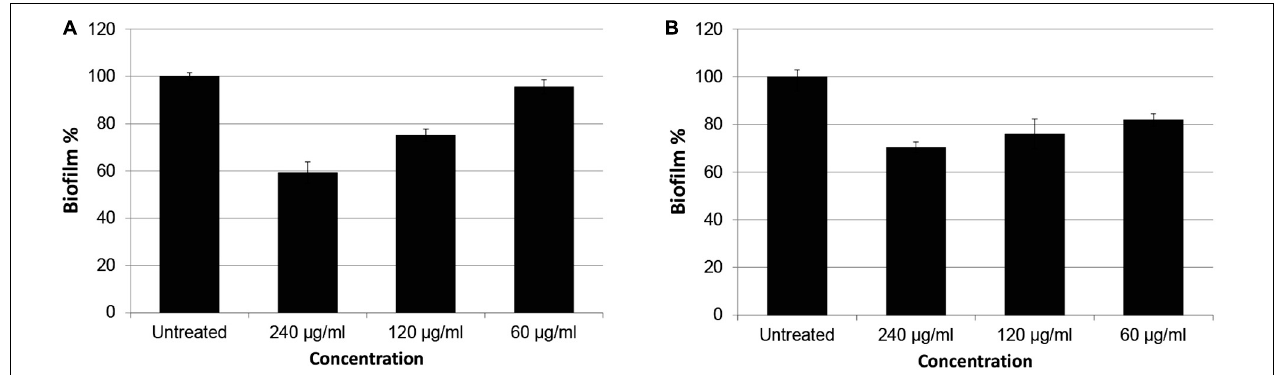
FIGURE 2 | Biofilm inhibition percentages of P. aeruginosa PAO1 treated with CFSE and CE obtained from N. versiforme. Biofilm mass of untreated samples are considered as 100. (A) PAO1 treated with CFSE, (B) PAO1 treated with CE.